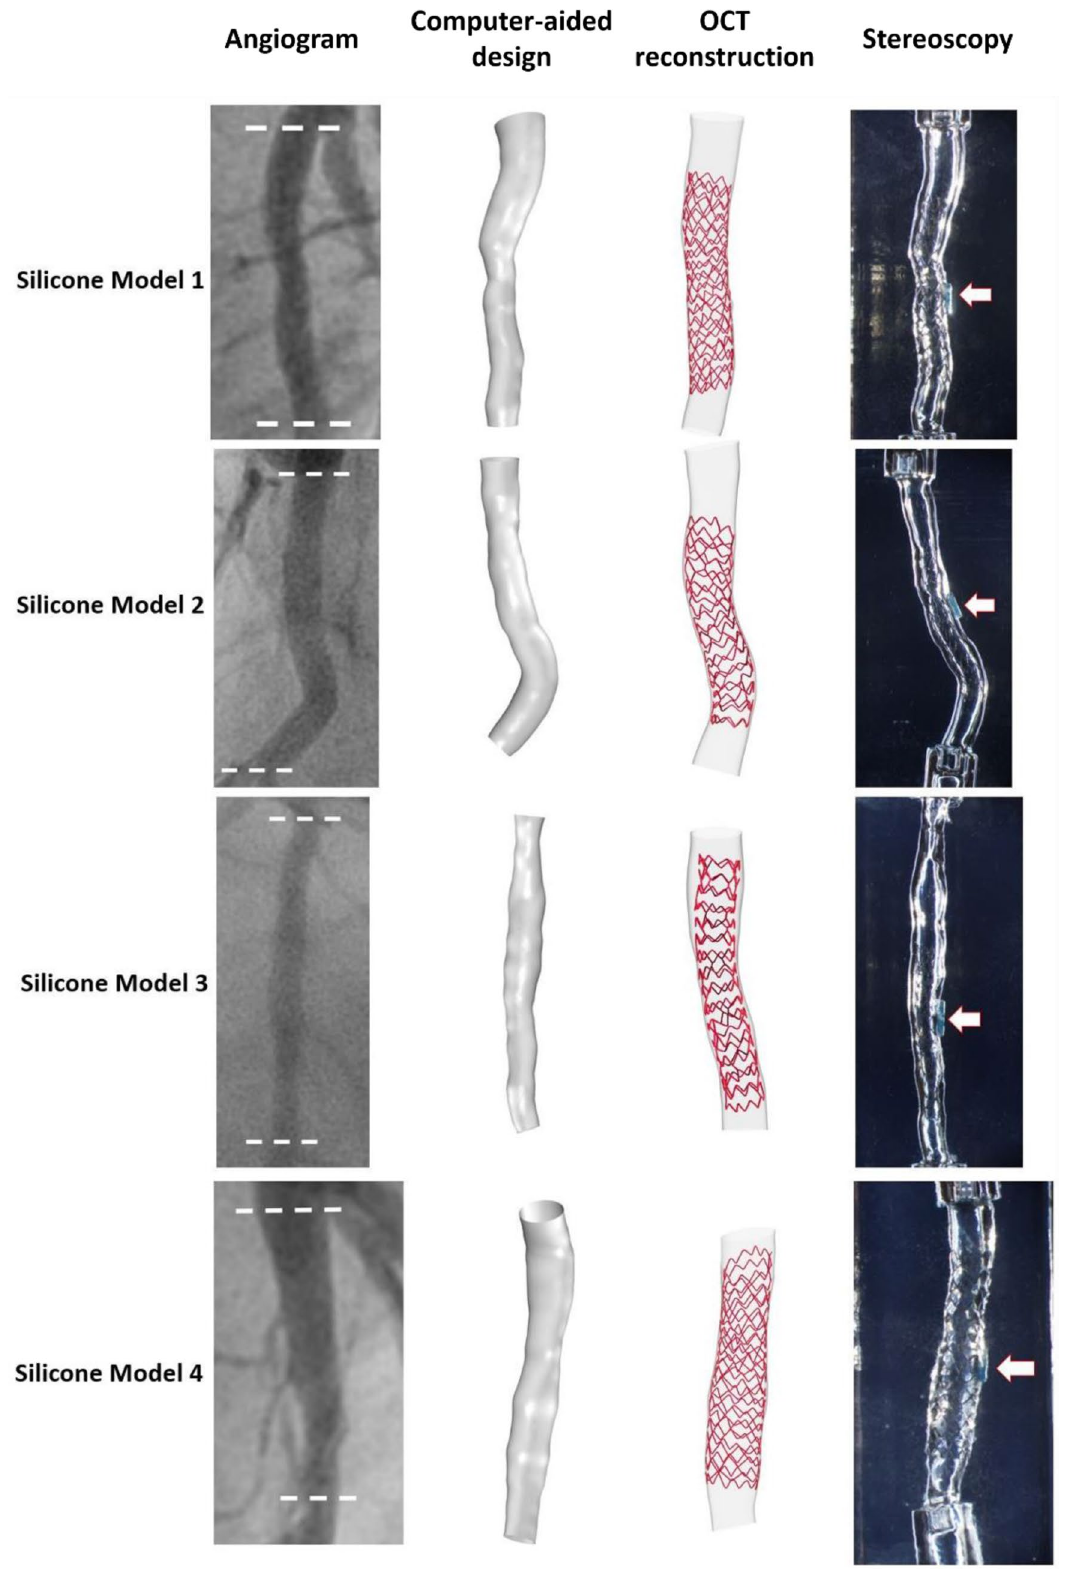
Figure 1. Patient-specific silicone models. In each model from left to right: angiography, computer-aided design before stenting, OCT-reconstructed lumen after stenting, and stereoscopy images of the final stented models. In stereoscopy images, the arrows indicate the markers used as reference for the orientation of the 3D reconstructed